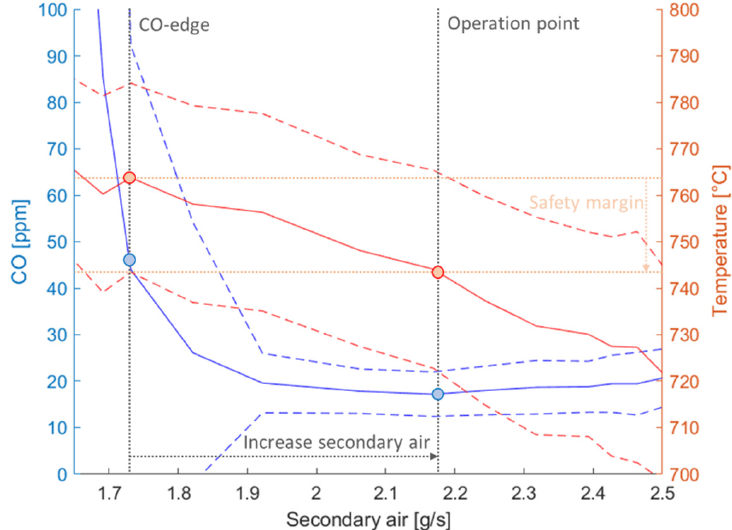
Figure 12. Influence of the secondary air supply to the temperature at the combustion chamber outlet (red) and CO emissions (blue) at 4 kW input power. Solid line represents the mean value and the dashed line the spectrum (standard deviation).